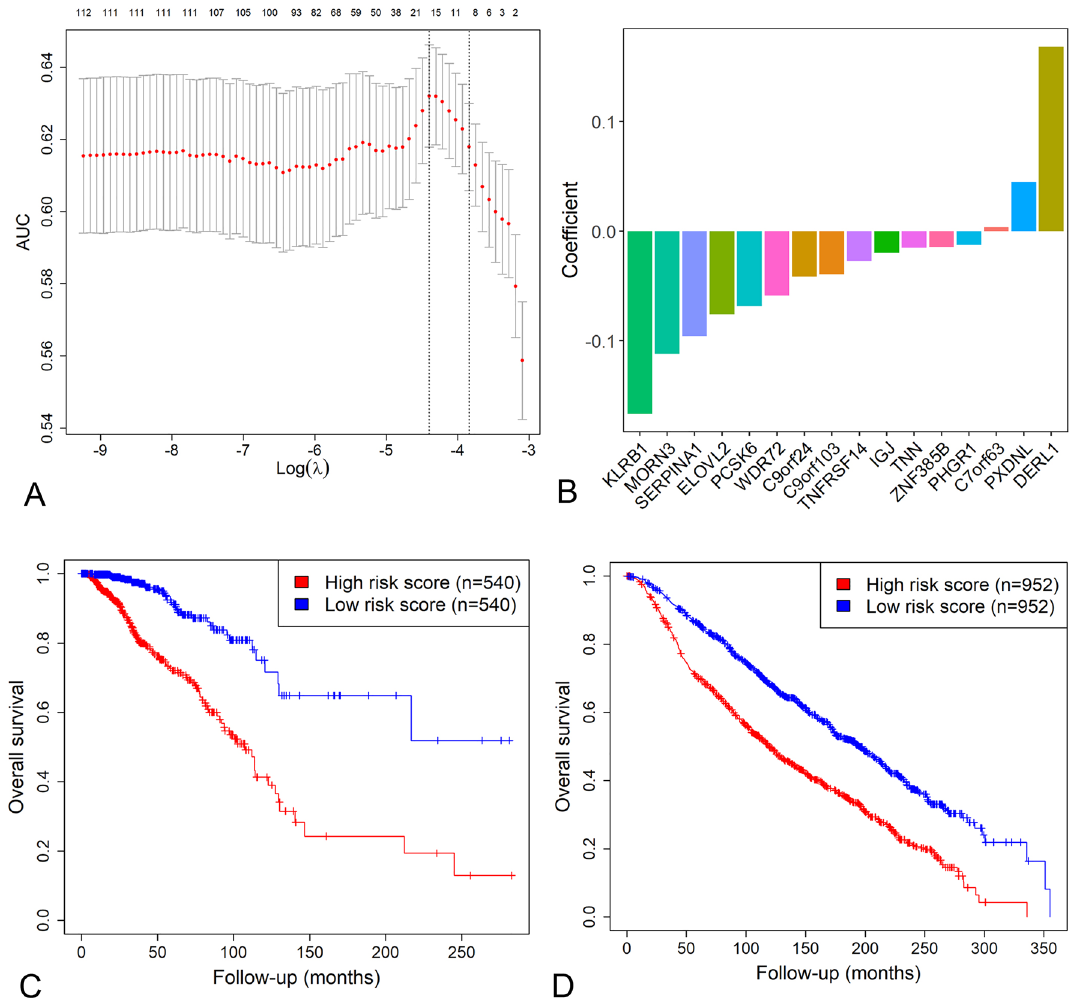
Figure 2. The 16-gene score is an indicator of infavorable survival in BRCA. ( A ) The relationship among AUC, log scaled lambda values and number of genes with non-zero coefficients in the LASSO model. The x axis represents the log value of the independent variable λ, whilst the y axis represents the partial likelihood deviance of the log value of each independent variable λ. ( B ) The coefficients of 16 genes in the LASSO model. ( C ) Kaplan–Meier survival curve of patients’ OS for BRCA patients with different 16-gene scores in the TCGA cohort, ( D ) Kaplan–Meier survival curve of patients’ OS for BRCA patients with different 16-gene scores in the METABRIC